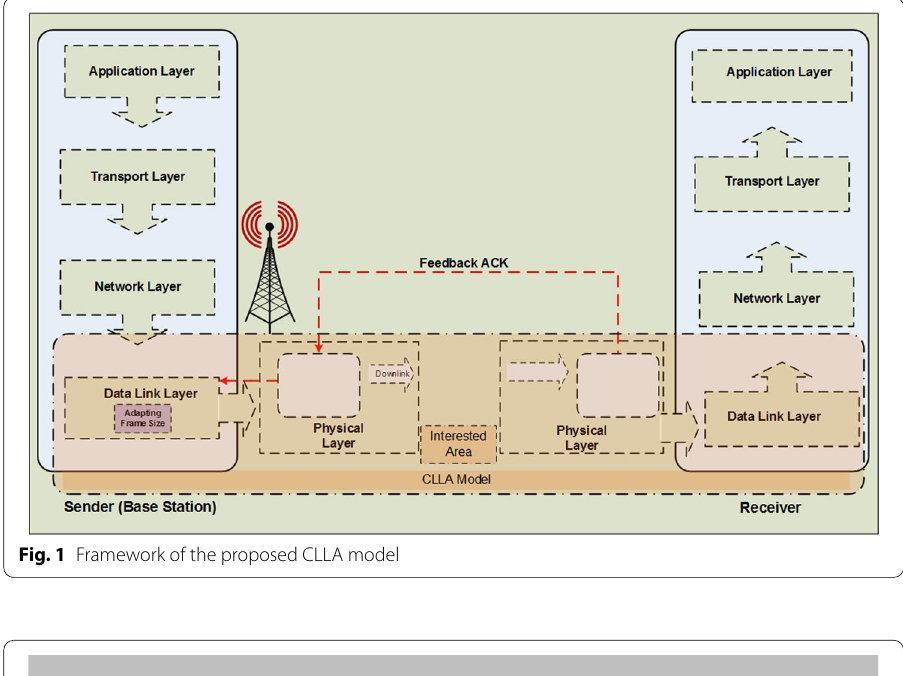
Fig. 1 Framework of the proposed CLLA model